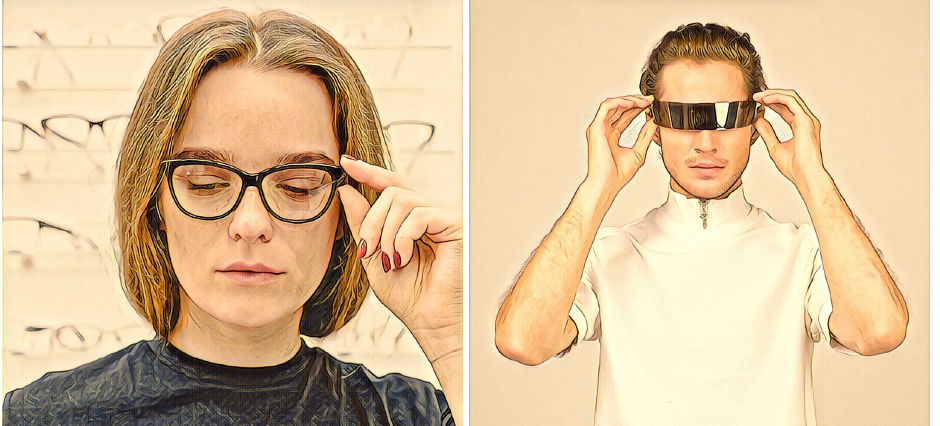
Figure 1. Illustrations of touch-based interaction